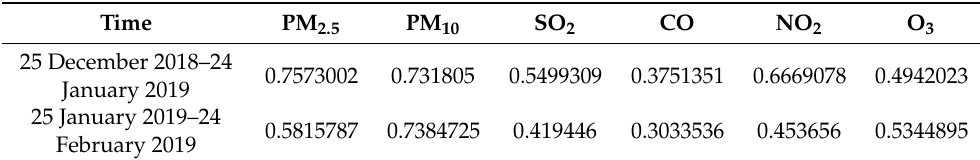
Table 6. The gray relational degree between pollutants and AQI between 25 December 2018 to 24